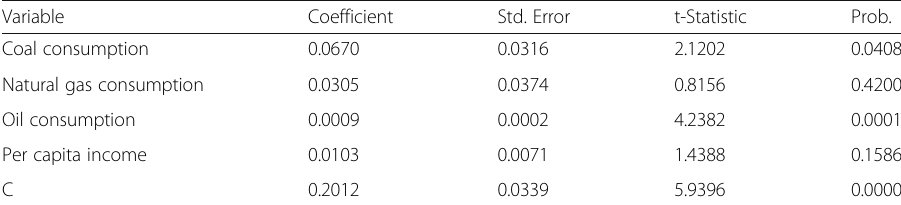
Table 5 Long Run ARDL Results